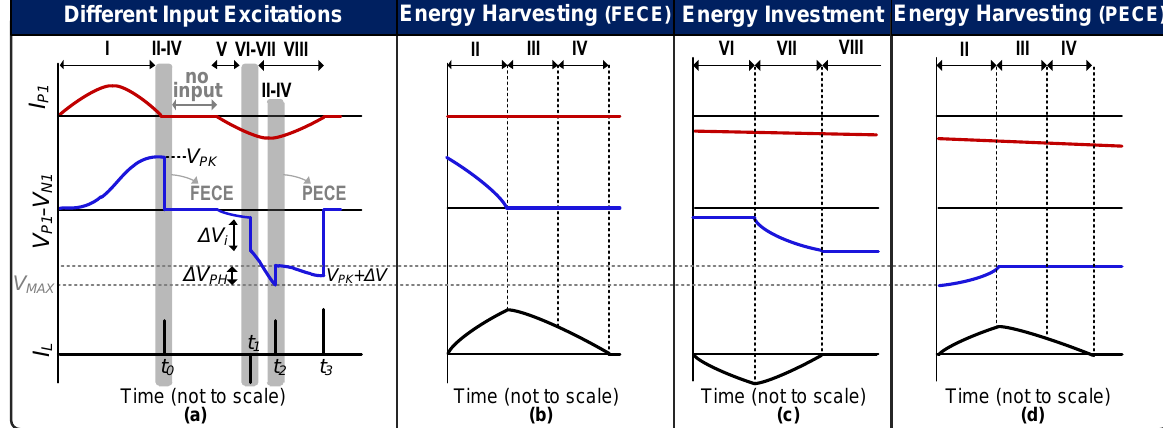
Figure 5. Conceptual waveforms of the proposed PZT energy-harvesting interface while activating only PZT 1 . ( a ) PZT- generated output for different positive and negative input excitations. ( b ) Zoomed waveform with FECE operation phases of energy storage and harvesting. ( c ) Zoomed waveform with operation phases of energy investment. ( d ) Zoomed waveform of a PECE cycle.